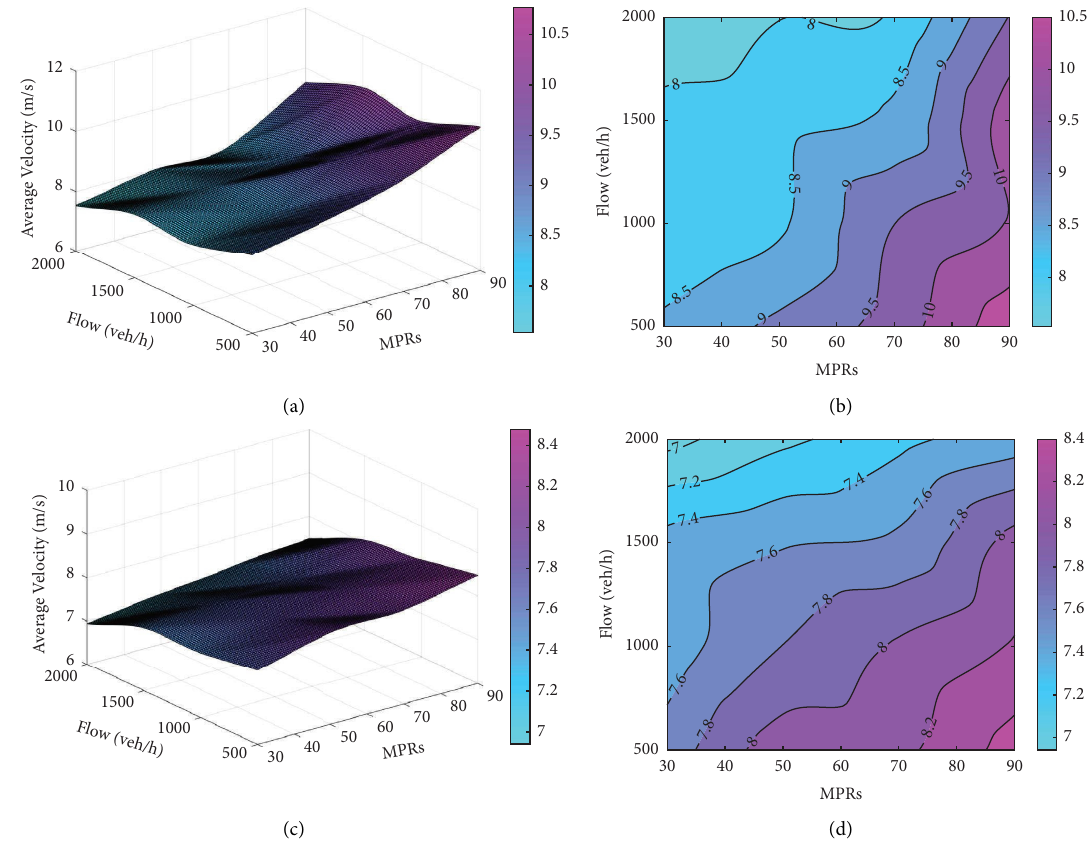
Figure 3: Comparison results of average velocity under diferent volumes and MPRs. (a) Average velocity of the proposed method in 3D. (b) Average velocity of the proposed method in 2D. (c) Average velocity of the benchmark method in 3D. (d) Average velocity of the benchmark method in